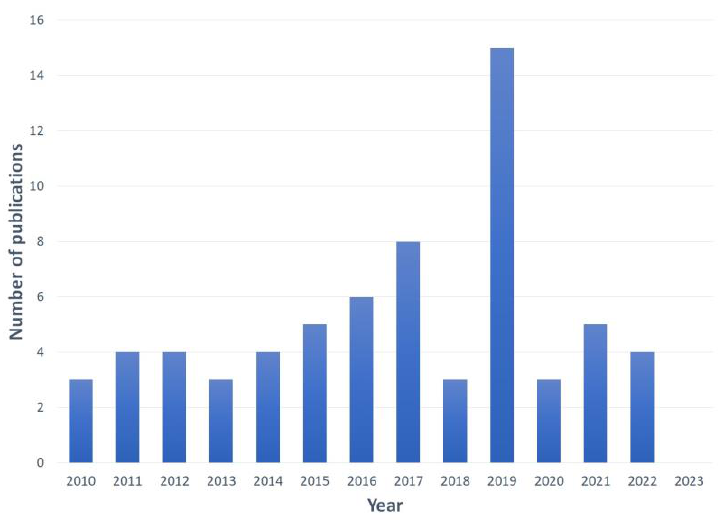
Figure 9. Yearly scientific production regarding biosensors for the detection of pollutants in water.